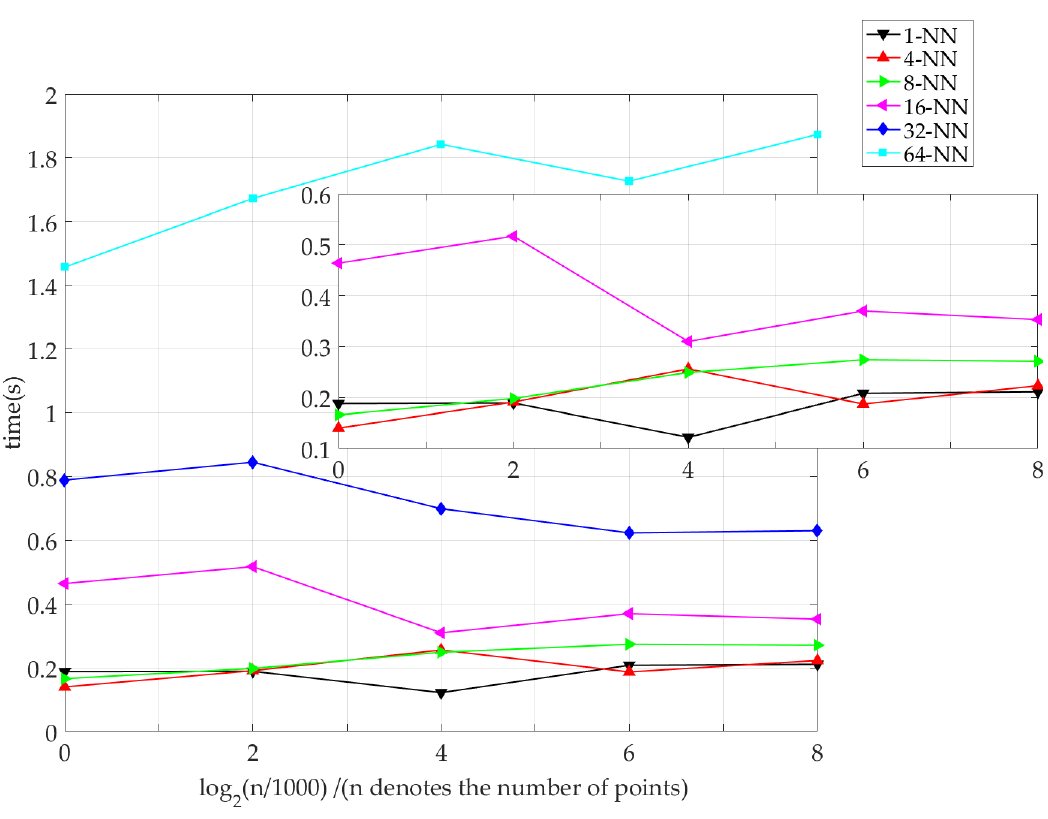
Figure 6. NN-searching time of hybrid structure.